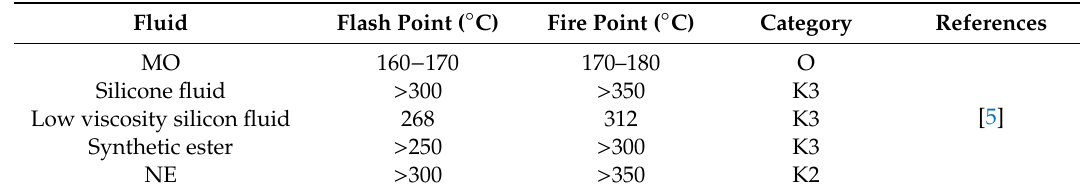
Table 11. Fire and flash points of various dielectric fluids.